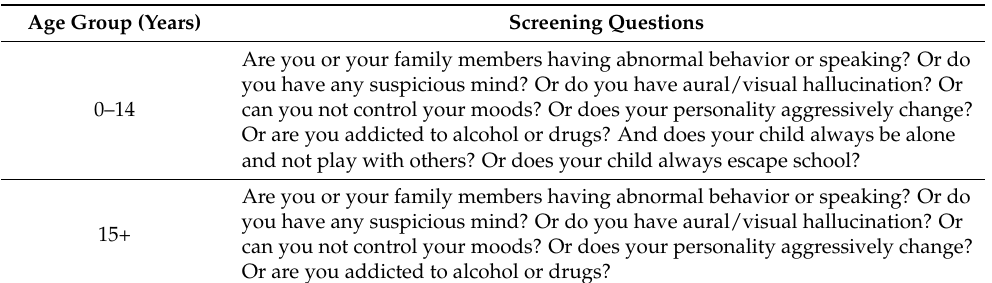
Table 1. Screening questions for mental disability in different age groups in 1987.